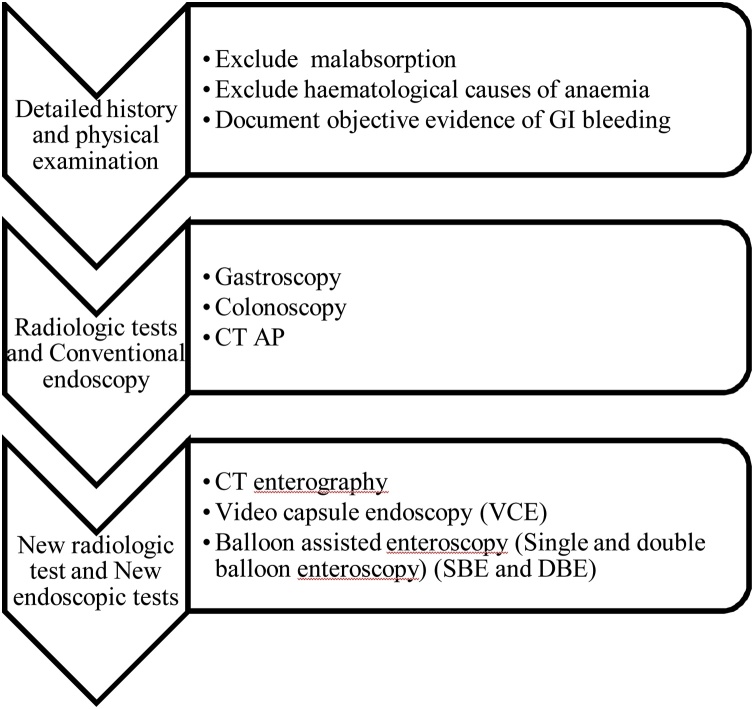
Sequence of investigation of OGIB in accordance to the ACG clinical guideline [2].